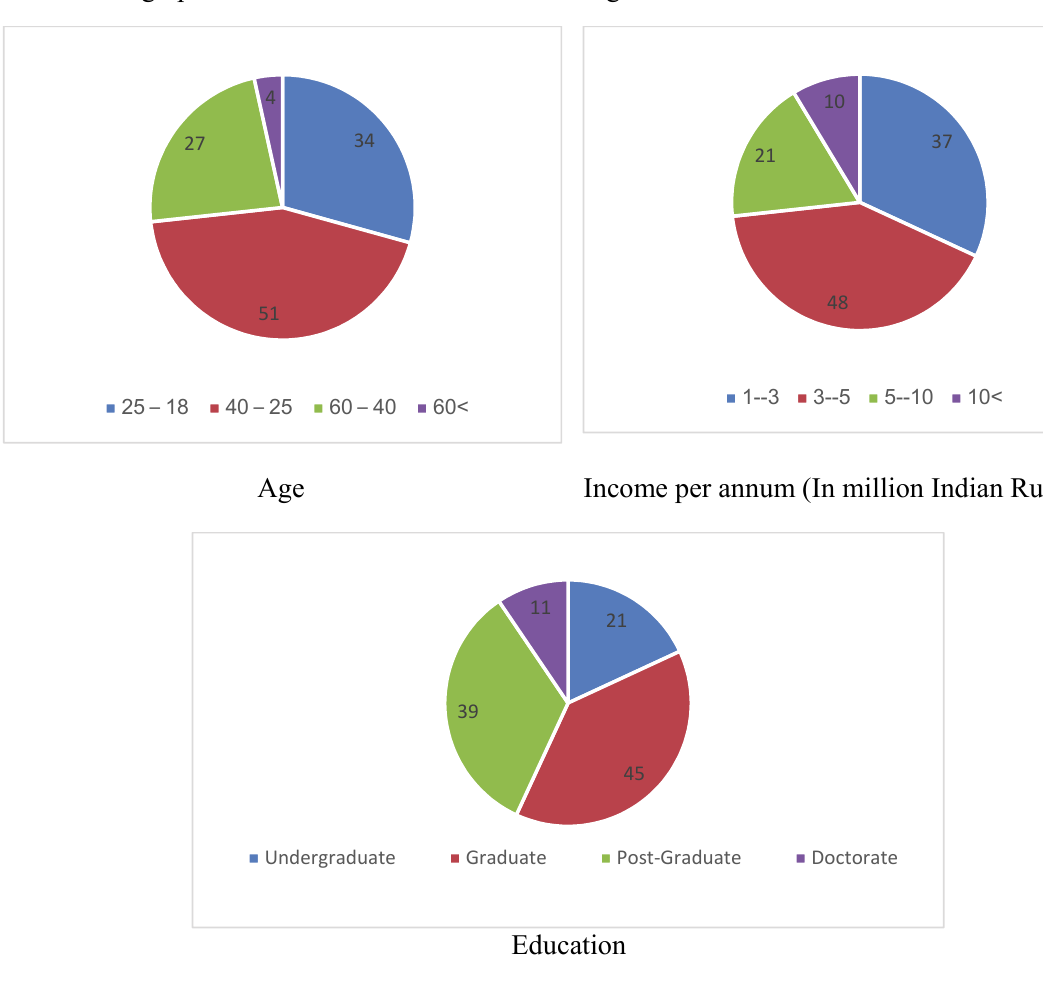
Fig. 2. Personal characteristics of the